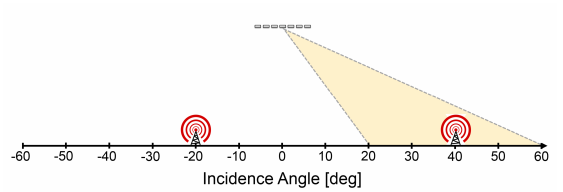
Figure 19. Scenario B: Two interferers are present. The first interferer is outside the swath at − 20° with baseband frequency 40 MHz. The second interferer is inside the swath at 40° with baseband frequency 25 MHz.